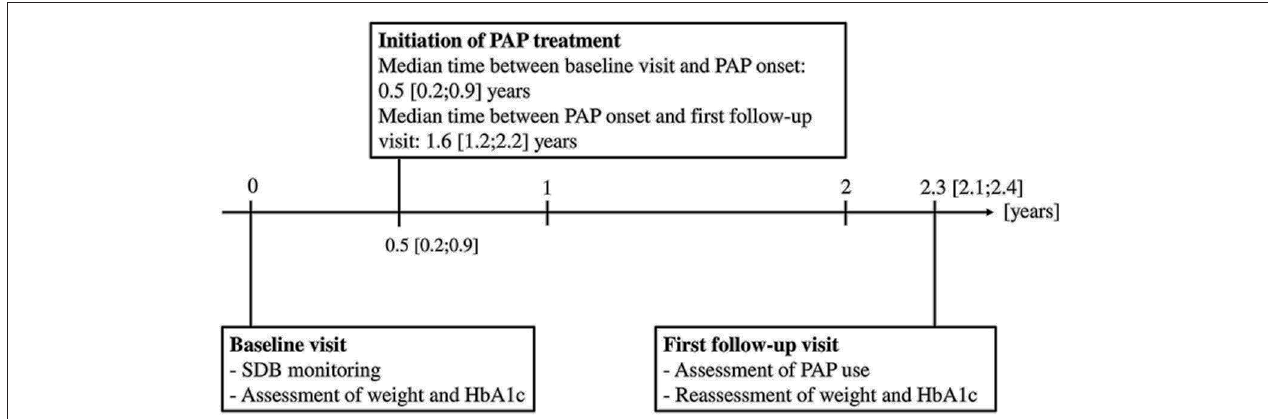
FIGURE 2 | Timeline of initiation of PAP treatment and assessment of clinical data within the median observation period of 2.3 (2.2; 2.4) years. The mean self-reported PAP usage was 6.2 ± 2.4 h/night. Total 87% of the patients in the SDB PAP group used their PAP device ≥ 4 h/night, 8% did not use their PAP device regularly. HbA1c, hemoglobin A1c; PAP, positive airway pressure; SDB, sleep-disordered